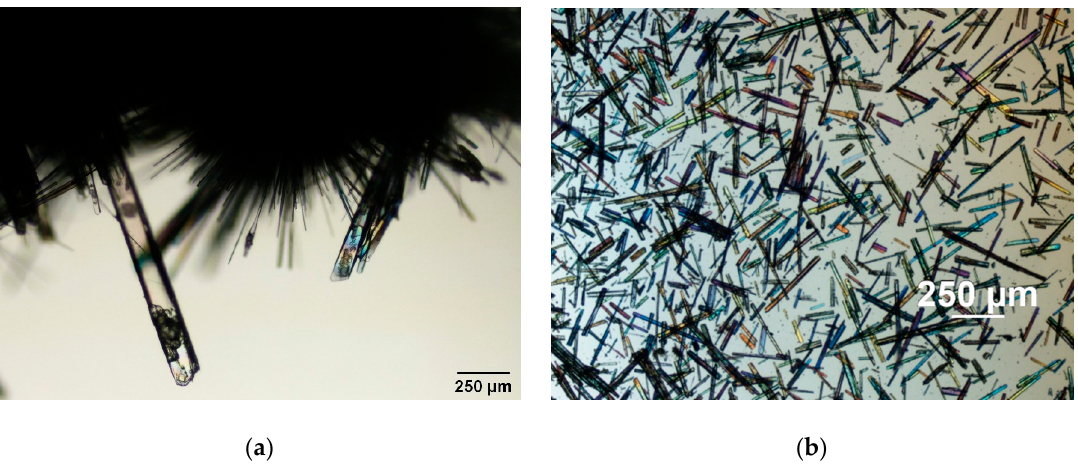
Figure 2. γ -NADA crystals obtained with cooling crystallization (50 °C–20 °C) in H 2 O. ( a ) γ -NADA crystal cluster after crystallization in 2 mL reaction tube in H 2 O with 300 rpm shaking. ( b ) Single crystals after crystallization in a small scale reactor with 150 rpm stirring and 10 mL volume.